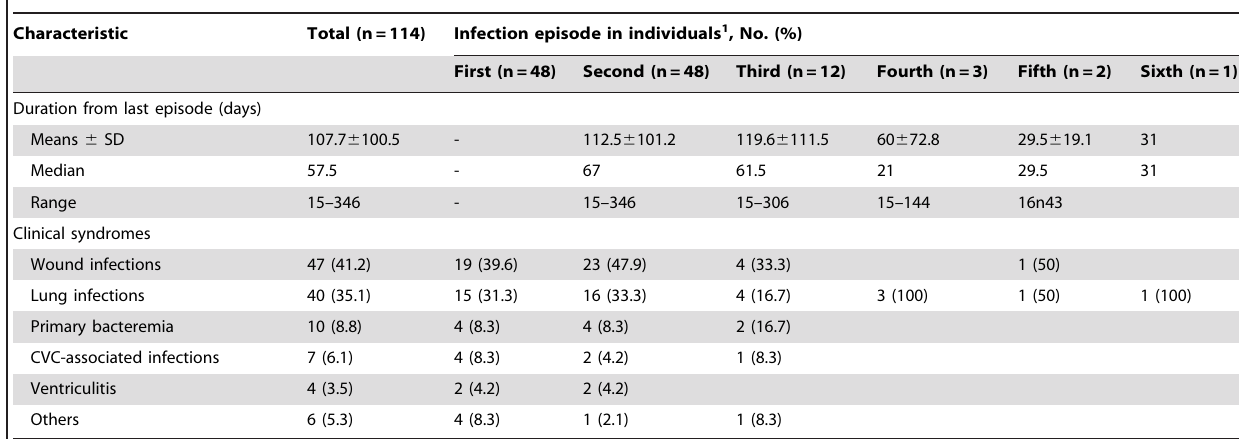
Table 2. Characteristics of repeated methicillin-resistant Staphylococcus aureus infections in 48 Taiwanese children.